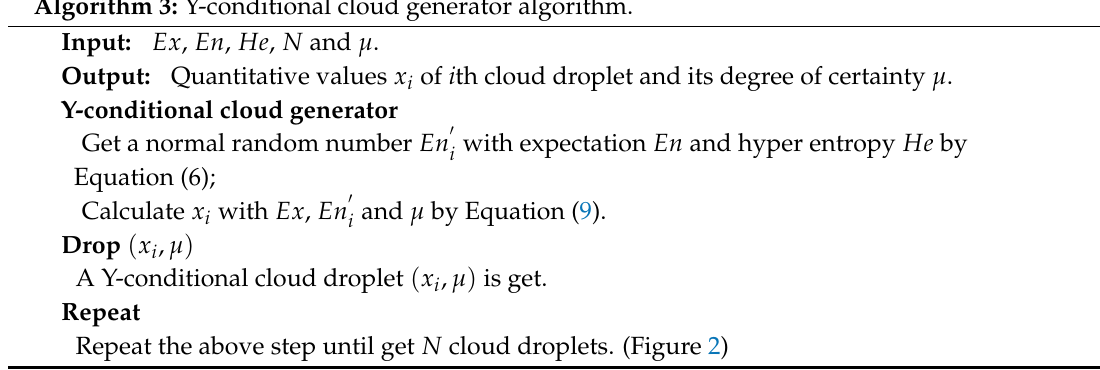
Algorithm 3: Y-conditional cloud generator algorithm.